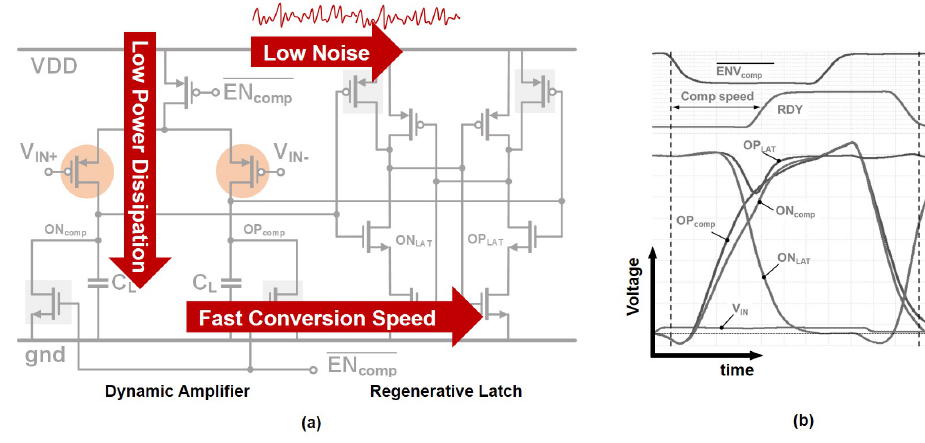
Figure 5. ( a ) Schematic of comparator and ( b ) waveform. Table 4. Design input parameters of the comparator module.